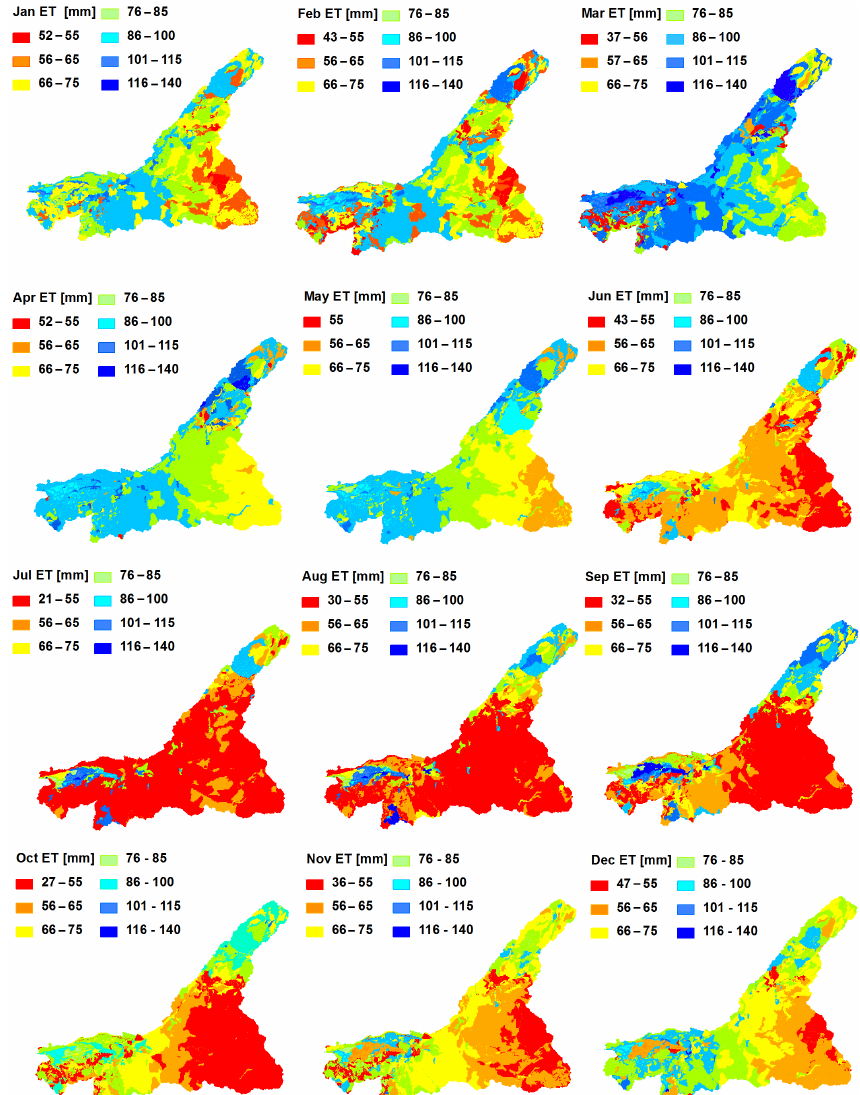
Figure 12. The average seasonal and spatial distribution of ET (2002–2009) in the Mara Basin, as simulated by the SWAT-T model at HRU